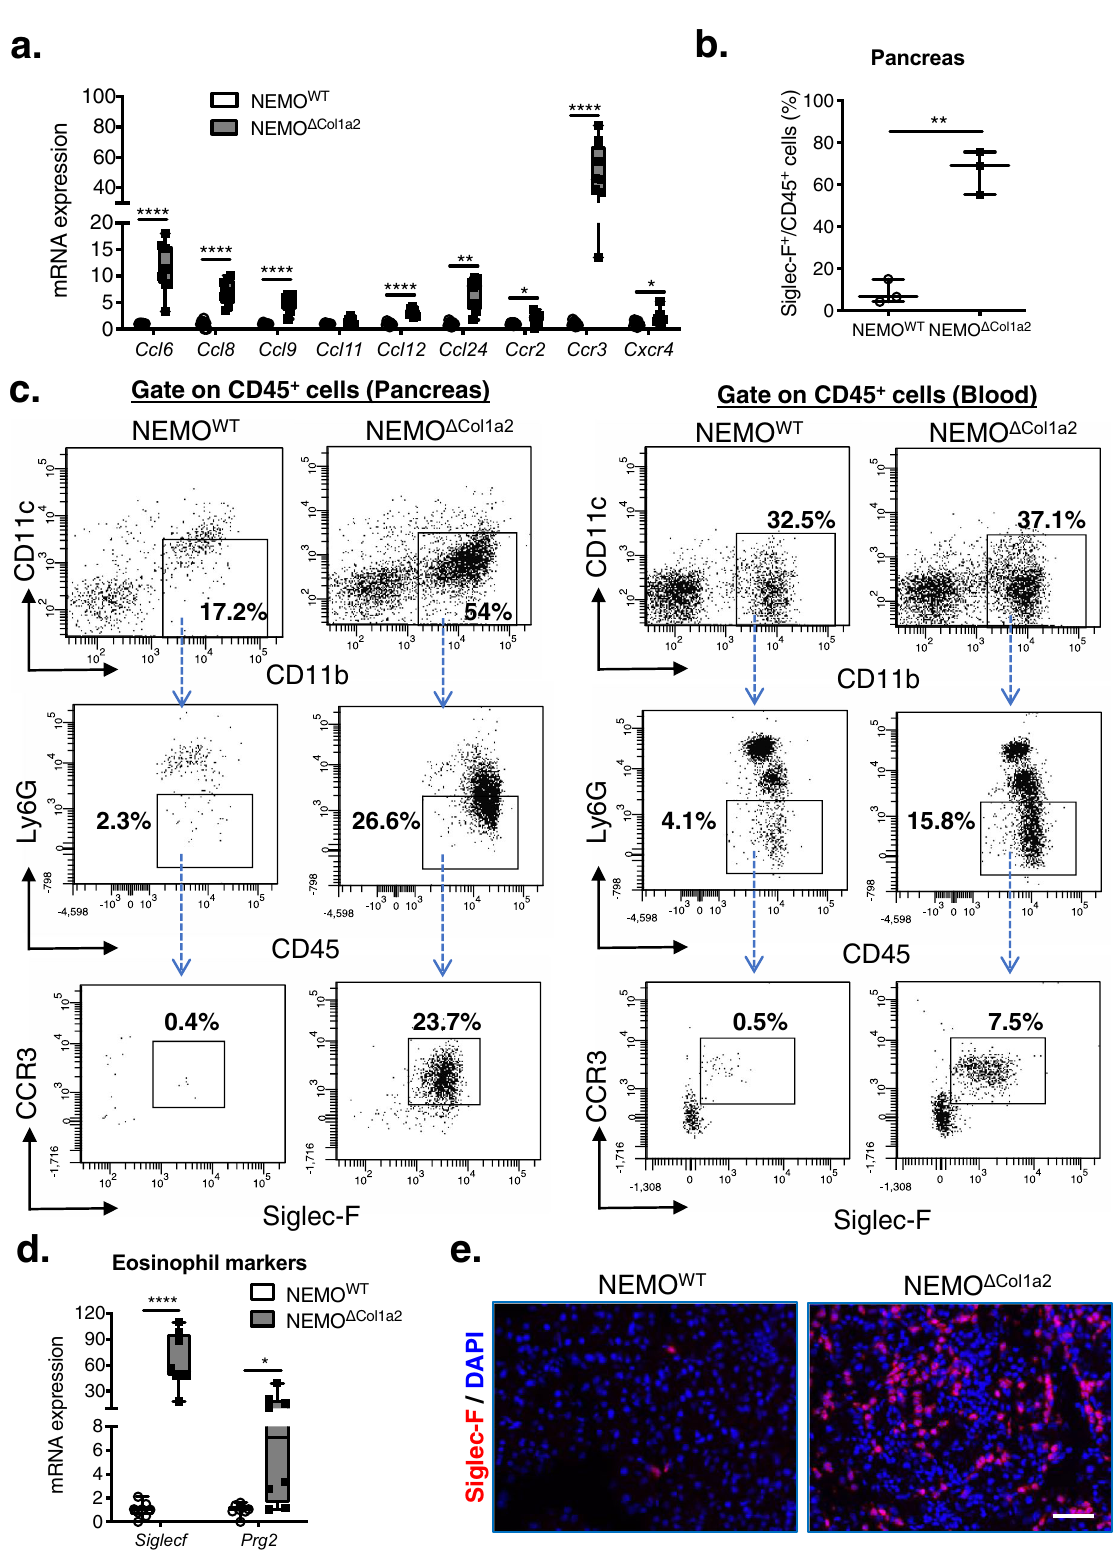
Fig. 3 Deletion of NEMO in PSCs promotes tissue and peripheral eosinophilia. a Expression of chemokines and chemokine receptors in pancreata analyzed by qPCR ( n = 8). b Percentage of Siglec-F + /CD45 + cells analyzed by FACS ( n = 3). c FACS analysis illustrating the eosinophil population (gate on CD45 + CD11b + CD11c − Ly6G − CCR3 + SiglecF + cells) in pancreas and circulation. d Expression of eosinophil markers ( Siglecf and Prg2 ) detected in the pancreata by qPCR ( n = 8). e Staining of Siglec-F on pancreatic tissues. DAPI: nuclei. Scale bar: 50 µ m. Whiskers: Min to Max. T -test (two-tailed): * p < 0.05; ** p < 0.01; **** p < 0.0001. All n numbers represent biological